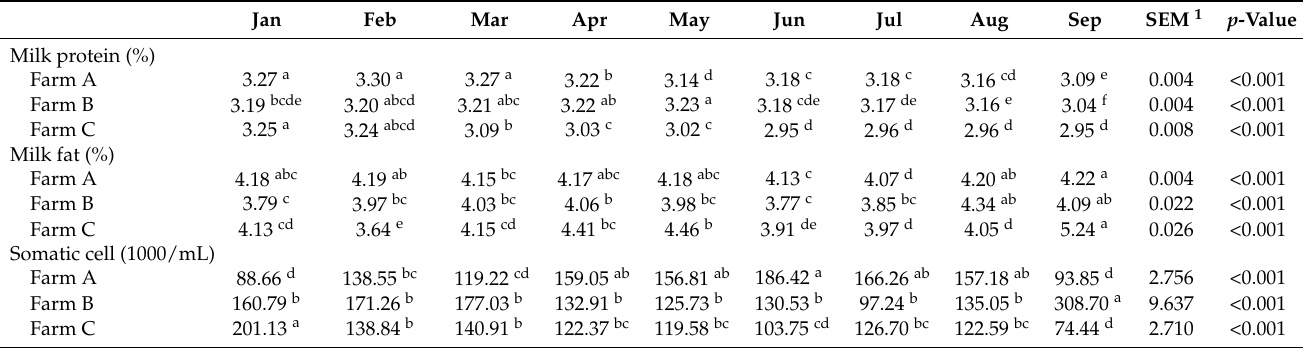
Table 3. Milk characteristics of lactating Holstein cows using the robot milking system at different farms from January to